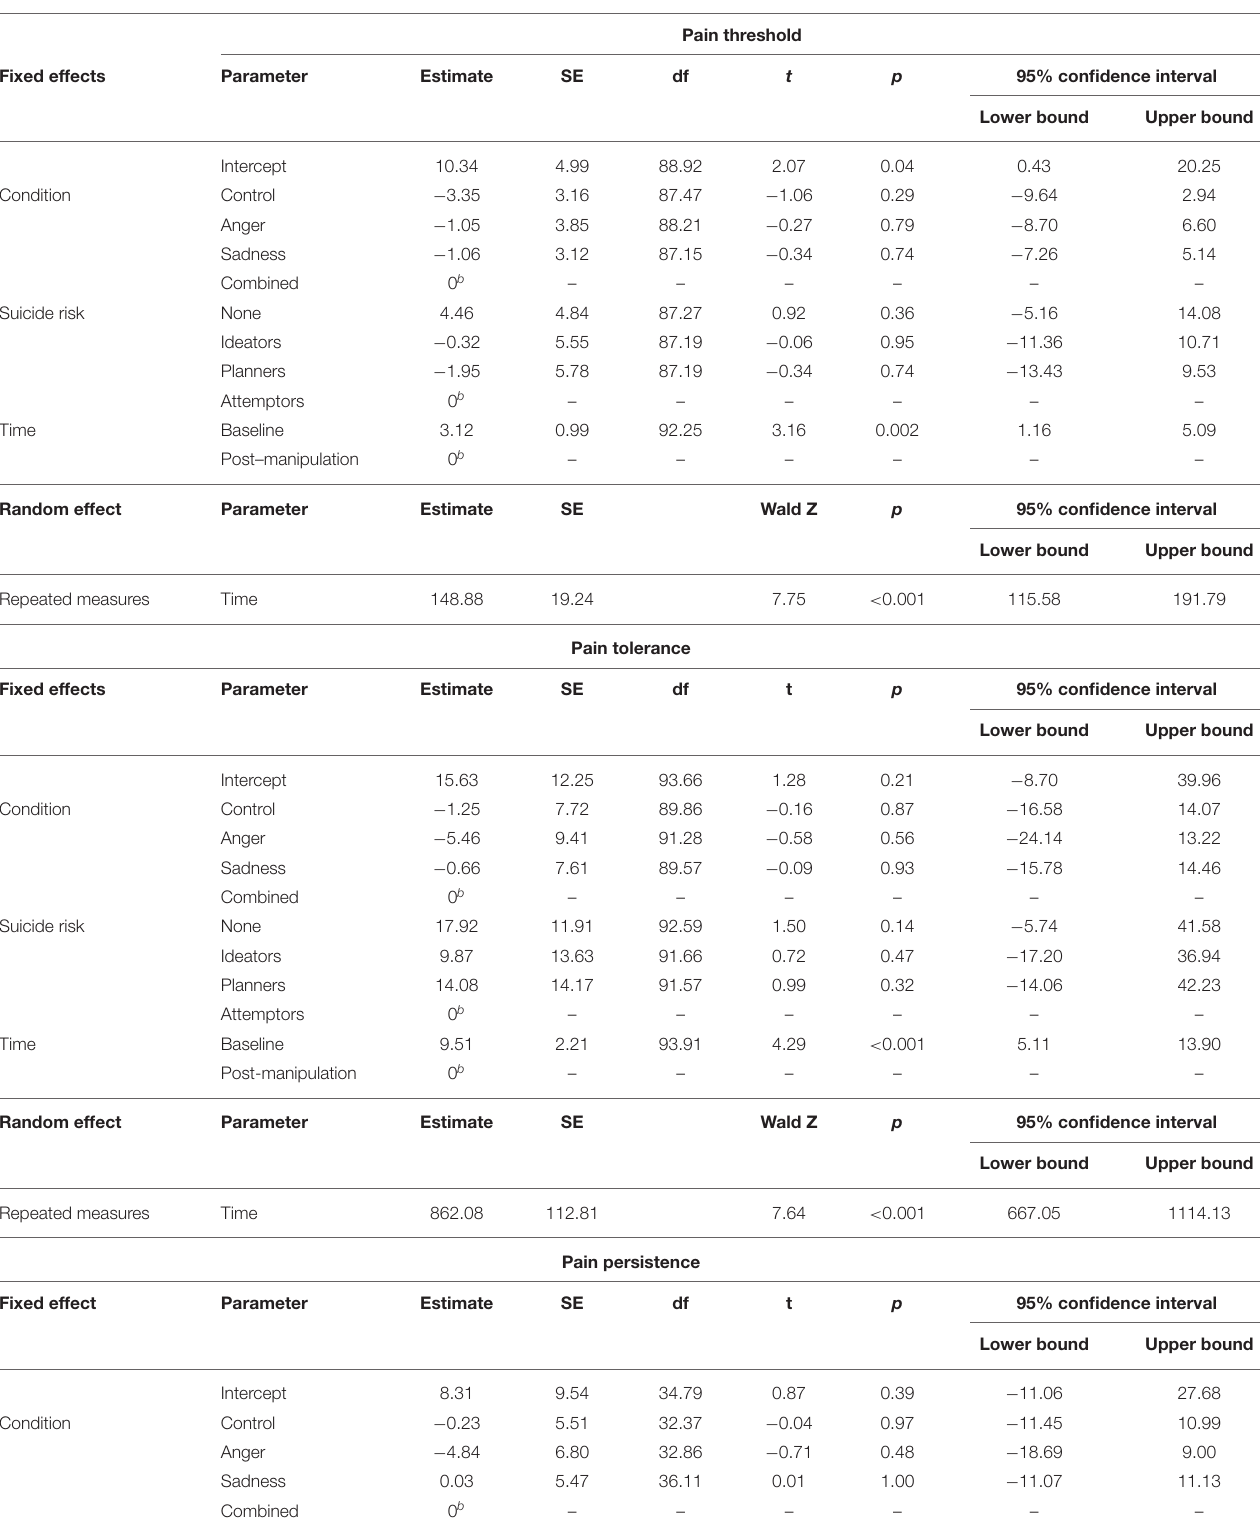
TABLE 4 | Study 1 fixed and random effects for pain